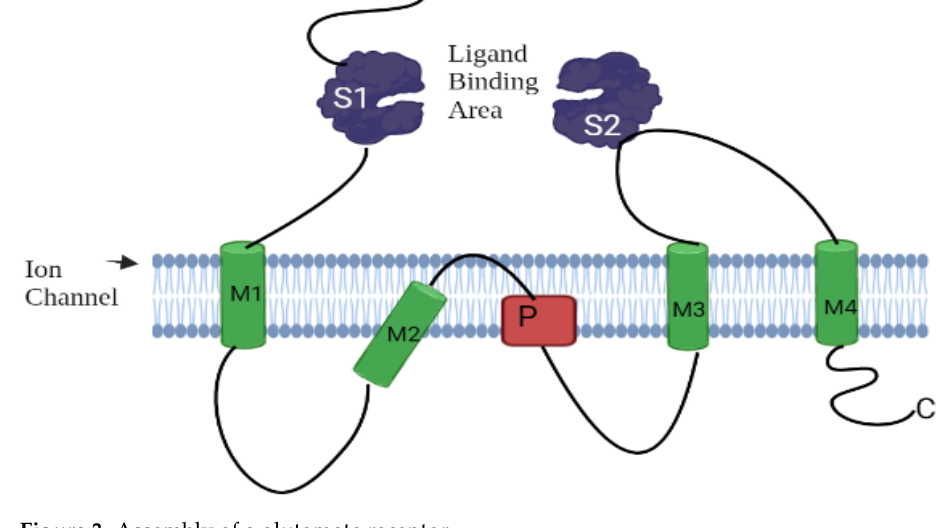
Figure 3. Assembly of a glutamate receptor.